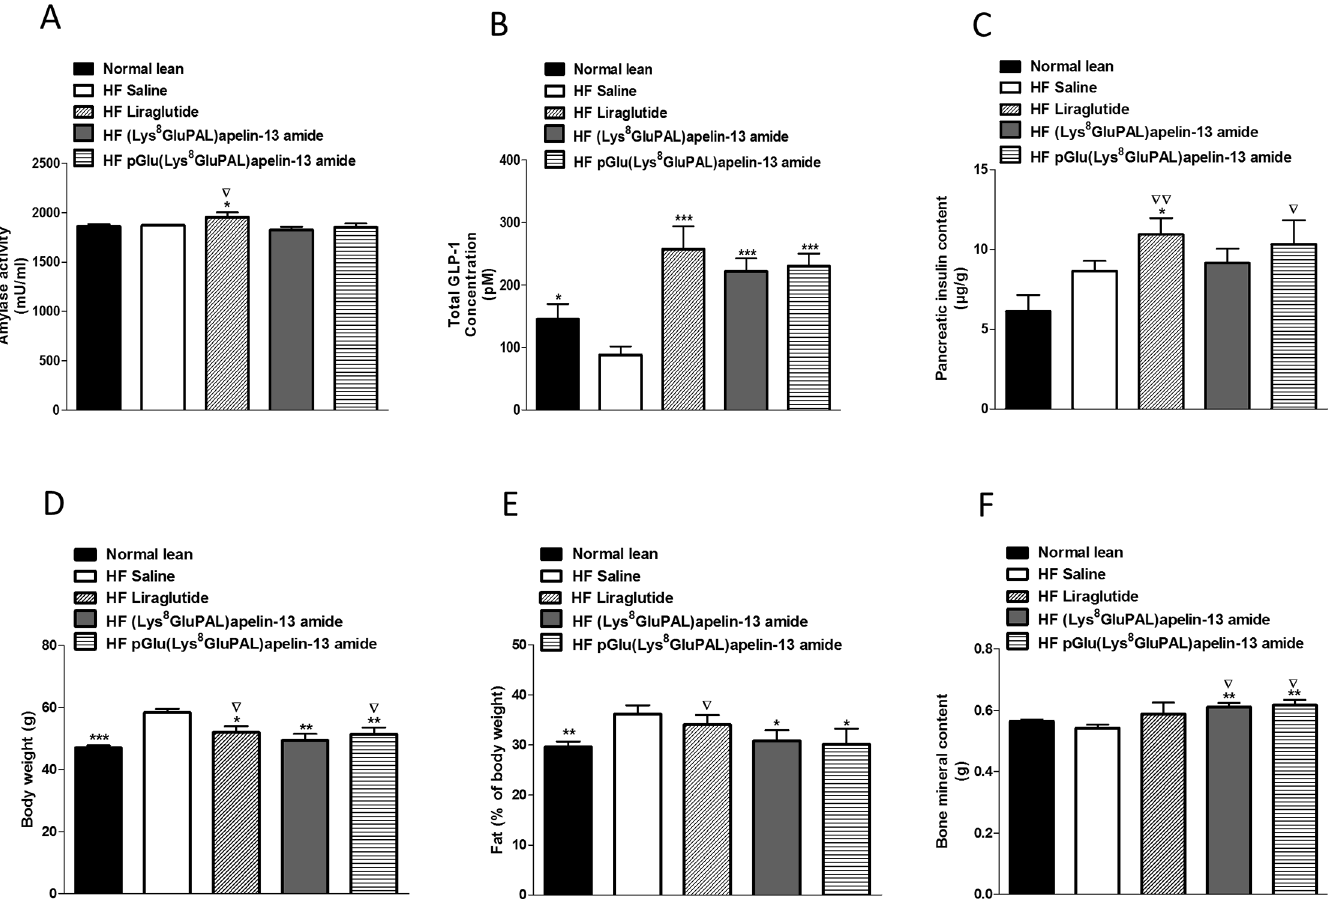
Fig 5. Effect of once daily i.p. administration of liraglutide, (Lys 8 GluPAL)apelin-13 amide or pGlu(Lys 8 GluPAL)apelin-13 amide (each at 25 nmol/kg bw) on α -amylase activity (A), plasma GLP-1 (B), pancreatic insulin content (C), body weight (D), fat mass (%) (E) and bone mineral content (F). Observations were made after 40 days of treatment of high-fat fed and lean control mice. Values represent the mean ± S.E.M. (n = 8) where (cid:3) p < 0.05, (cid:3)(cid:3) p < 0.01 and (cid:3)(cid:3)(cid:3) p < 0.001 is compared to high-fat fed saline treated mice, 5 p < 0.05 and 55 p < 0.01 is compared to normal mice.